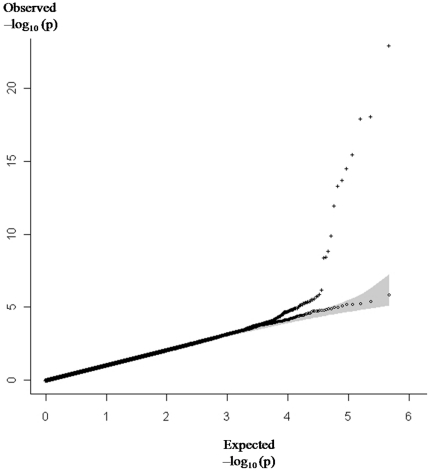
Quantile-Quantile plot representation of the GWAS results obtained from 491,258 studied SNPs.Q-Q plot derived from all SNP p-values is illustrated by + . The exclusion of 878 SNPs located within ±500 kb of the ABO, F5, FGG and FXI loci, the four main well-established VT-associated loci, lead to the Q-Q plot symbolized by ○ with its 95% confidence interval in shaded area.